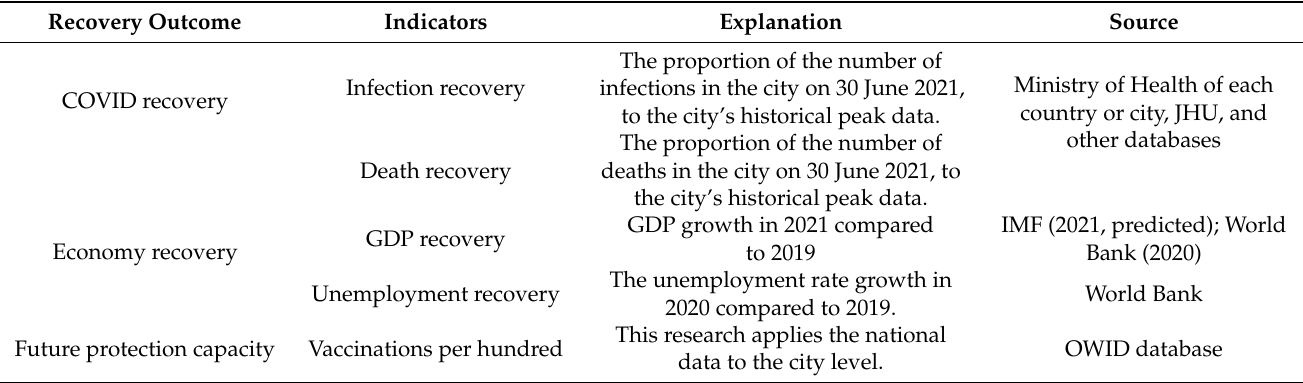
Table 2. Recovery